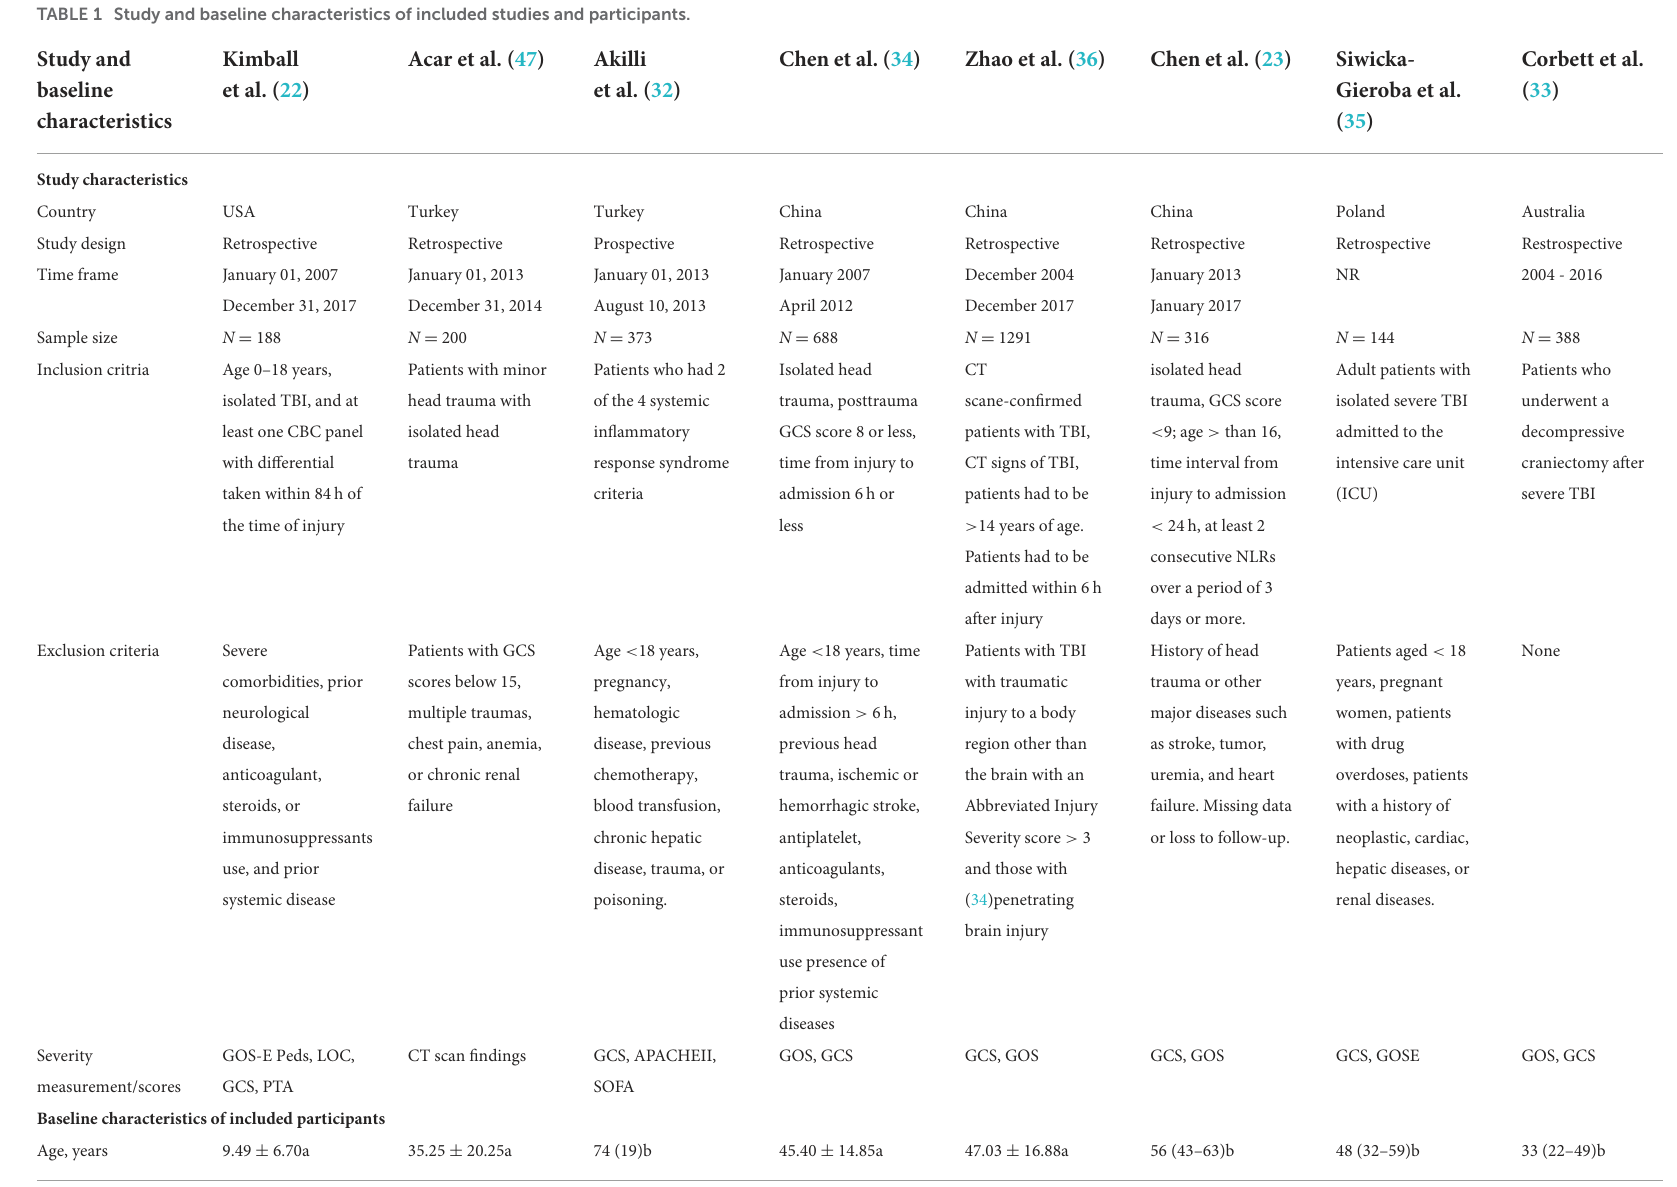
TABLE 1 Study and baseline characteristics of included studies and